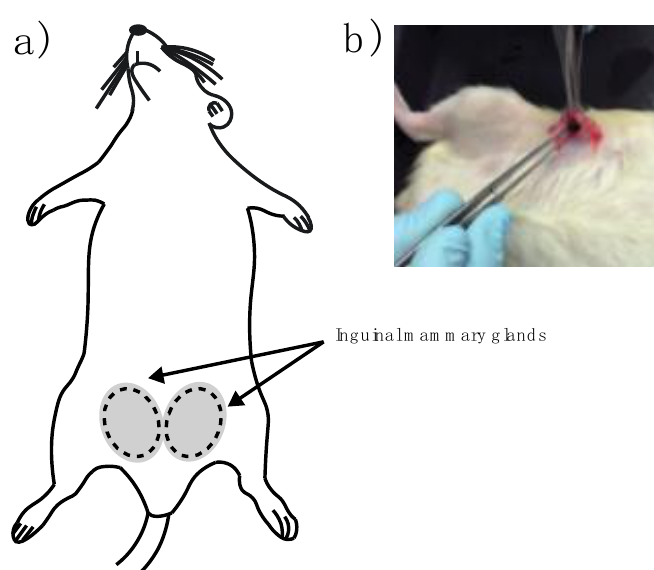
Figure 2. ( a ) Schematic representation of inguinal mammary glands of the rat and ( b ) composite marker clip implant into the inguinal mammary gland of Wistar rat by biopsy.